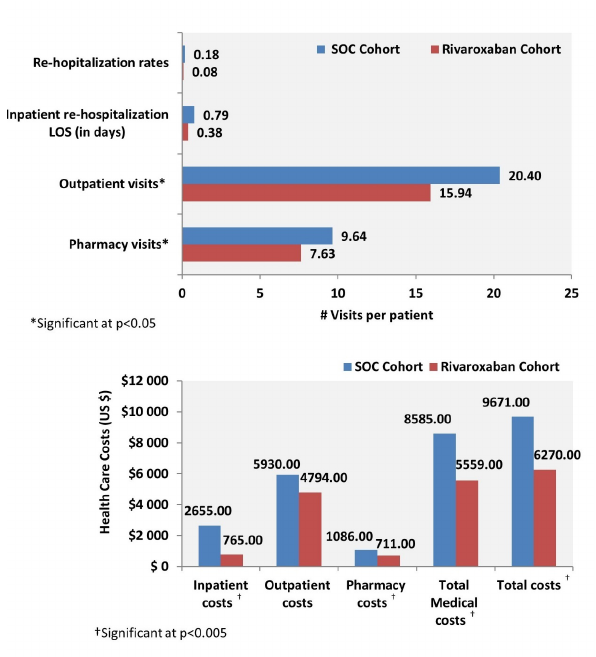
Figure 2. PSM-adjusted HRU and Costs among LRPE Patients Prescribed SOC Therapy versus Rivaroxaban During the 90-day Follow-up Period HRU: healthcare resource utilization; LOS: length of stay; LRPE: low-risk pulmonary embolism; PSM: propensity score matching; SOC: standard of